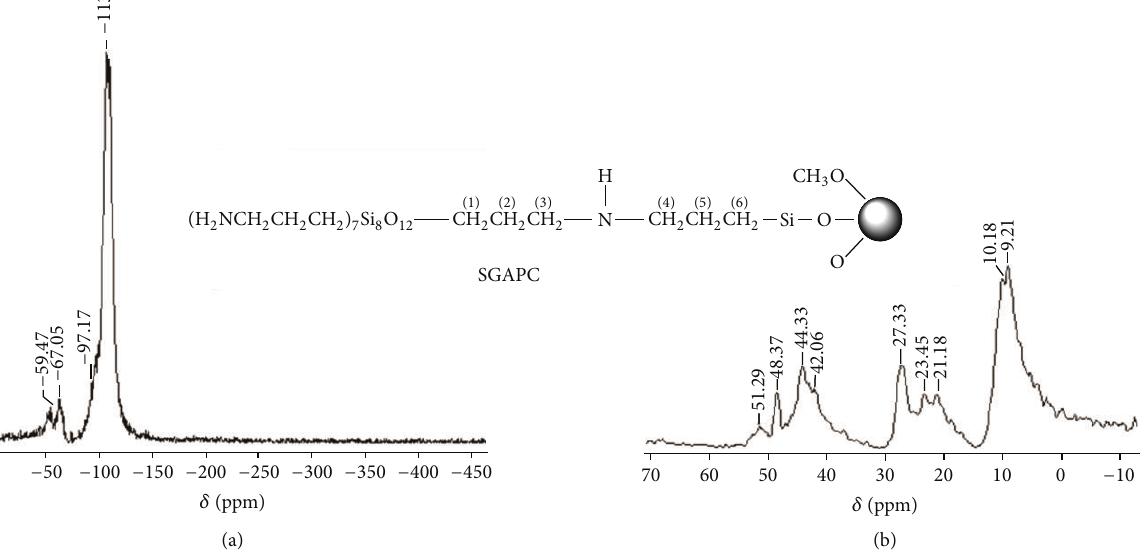
Figure 4: NMR solid state for SGAPC: (a) 29 Si; (b) 13